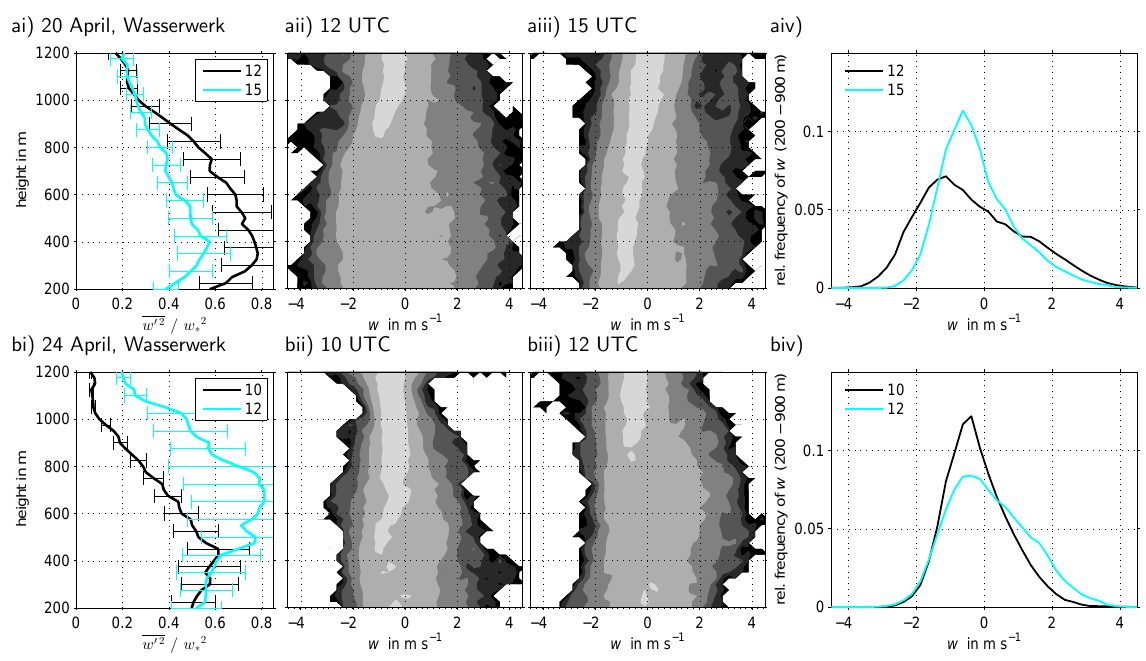
Figure 9. Normalized variance profiles with error bars (statistical error according to Lenschow et al., 1994); for each (ai) and (bi) , two time steps were selected from Fig. 7b and f, respectively; for each time step, frequency distributions are given as a function of height ( aii , aiii , bii , and biii , gray shading with steps proportional to logarithm of relative frequency, higher values for lighter shadings) and as distributions over a range of heights (aiv, biv) .